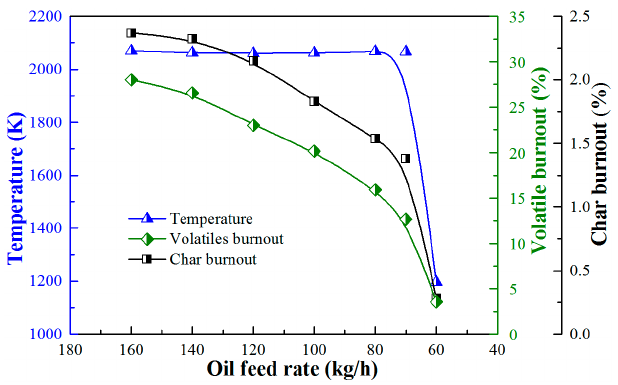
Figure 15. Main parameters at the burner exit for different oil feed rates.